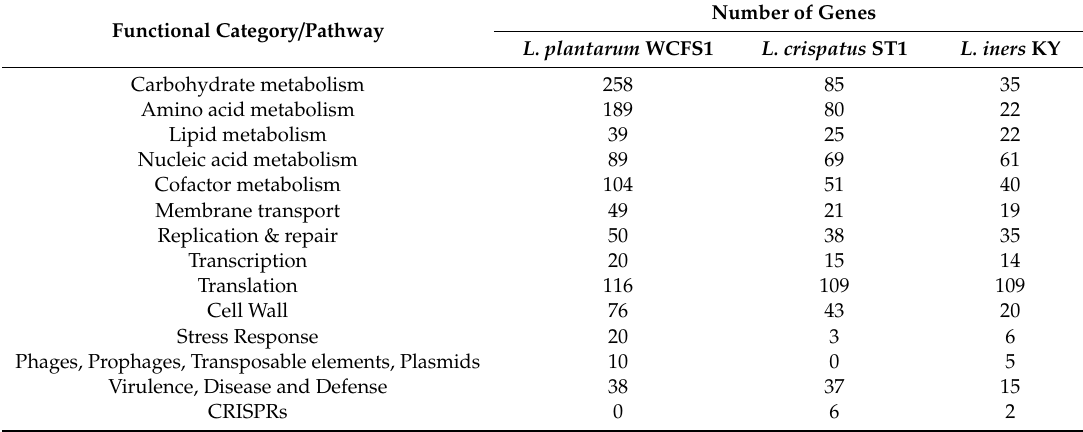
Table 1. Functional categories of genes in genomes of L. plantarum WCFS1, L. crispatus ST1, L. iners